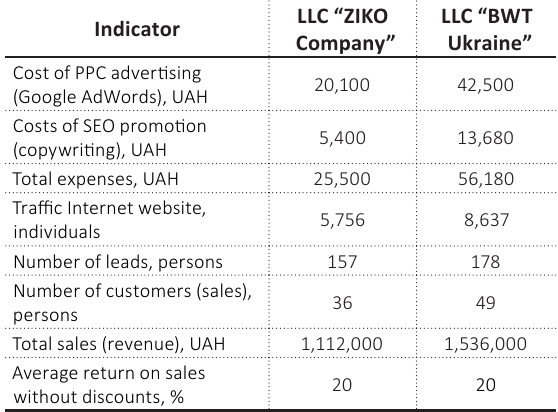
Table 1. Main indicators of interaction with clients of LLC “ZIKO Company” and LLC “BWT